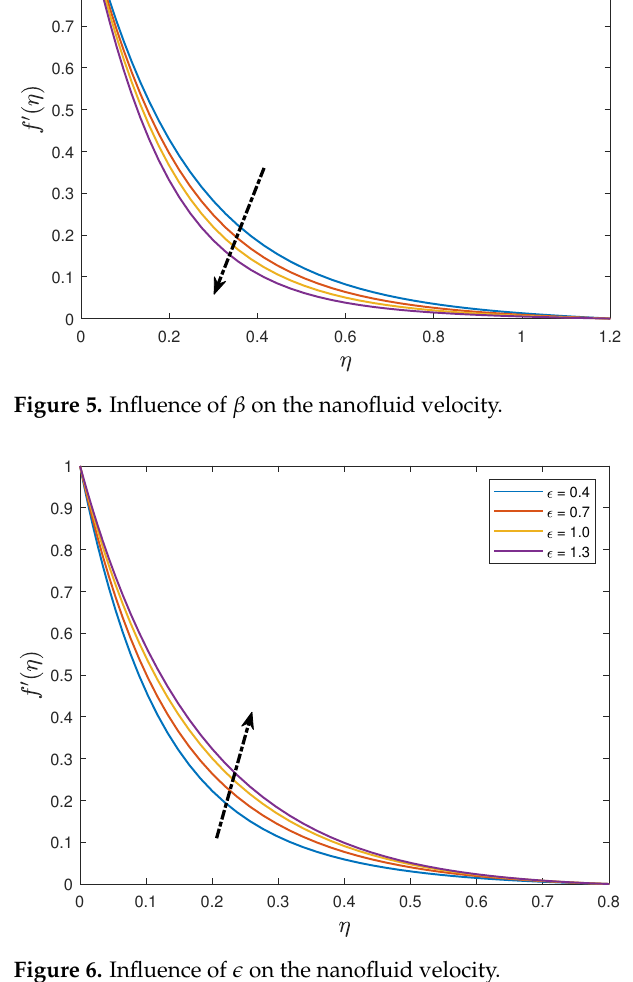
Figure 6. Influence of (cid:101) on the nanofluid velocity.